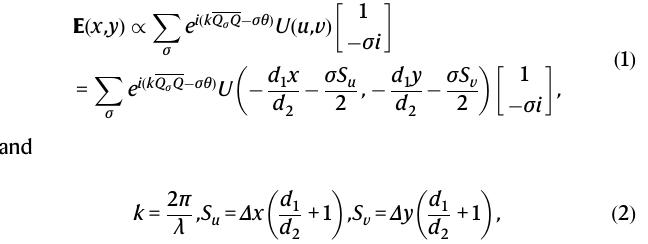
Fig. 2 | Spatial mapping relationship of the spin-decoupled metalens. a Oppositespincomponentsofpixels Q +1 and Q − 1 attheobjectplaneareimagedby thespin-decoupleddual-axismetalensandcoherentlysynthesizedatthepixel Q on the image plane. b Schematics of the spin-decoupled metalens with the nanopillar building block shown in the inset. The width W , length L , and spatial orientation α are spatially engineered according to the phase pro fi les of LCP and RCP.